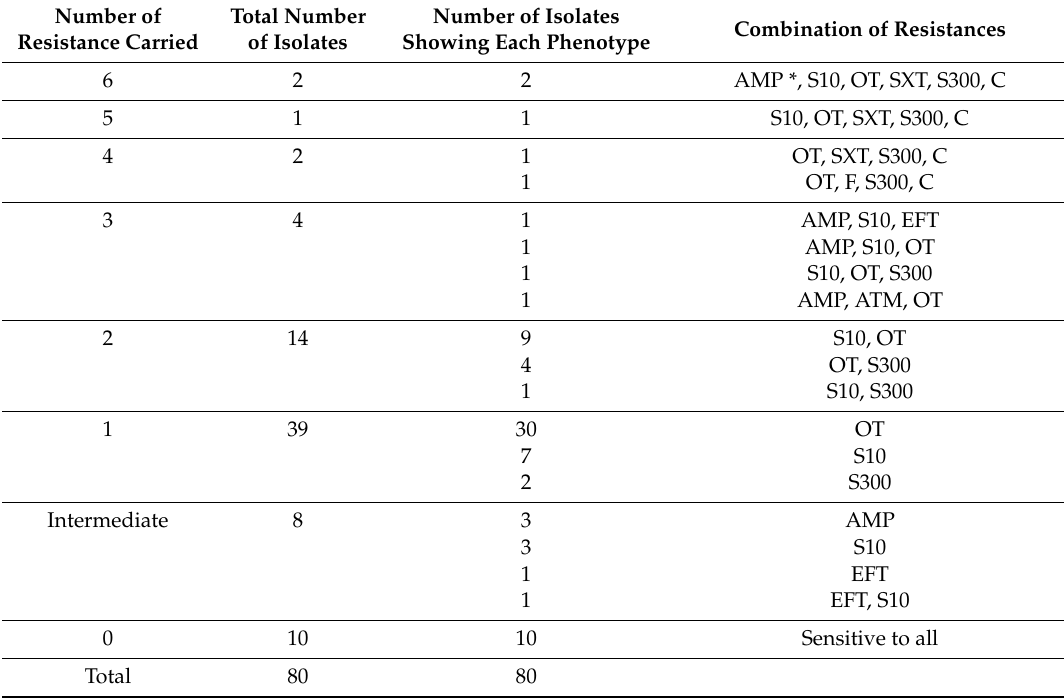
Figure 2. Percentage of E. coli resistant to different numbers of antibiotics. R-1~R-6: resistant to 1~6 antibiotics, respectively. Table 1. Antibiotic resistance combinations found in E.coli isolates.